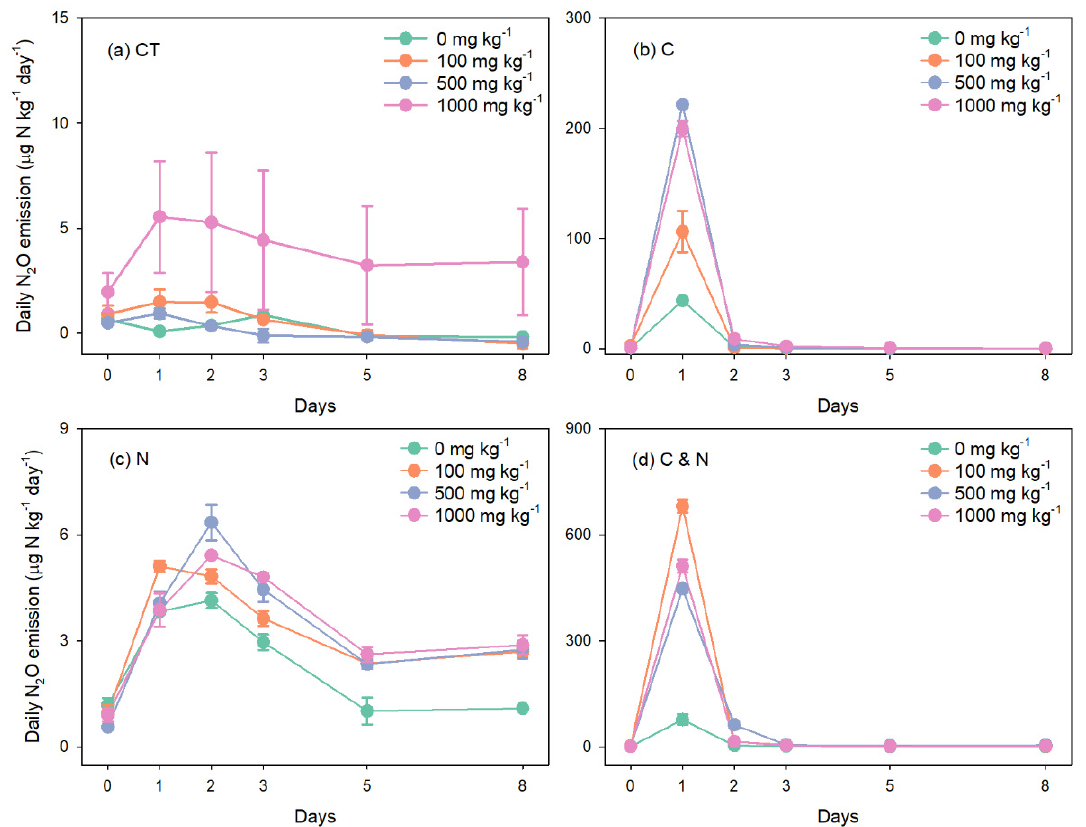
Figure 1. N 2 O emissions in the treatments with no addition ( a ), C addition ( b ), N addition ( c ), and C and N addition ( d ) at different ZnO NPs concentrations (0, 100, 500 and 1000 mg kg − 1 ). Error bars represent the standard error of the mean ( n = 3).